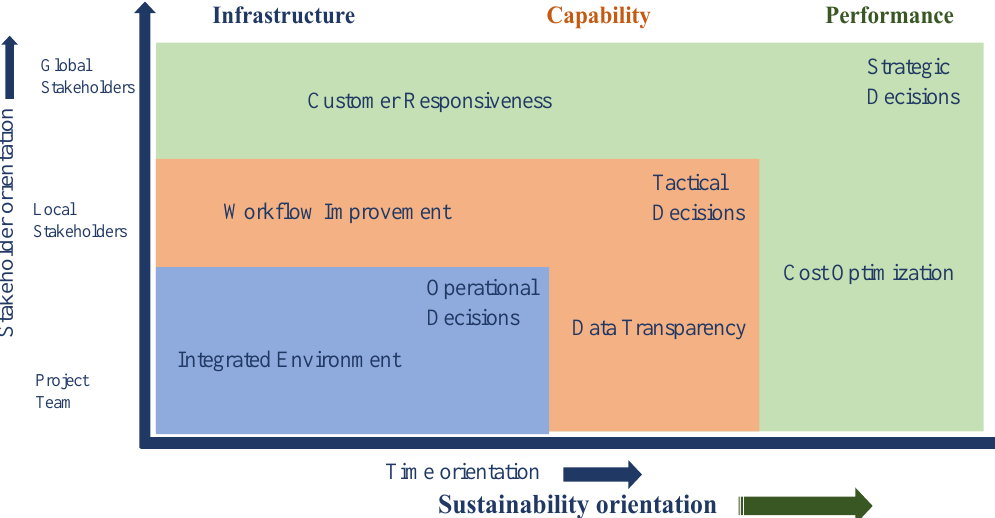
Figure 3. Motivational factors for an ERP system implementation.